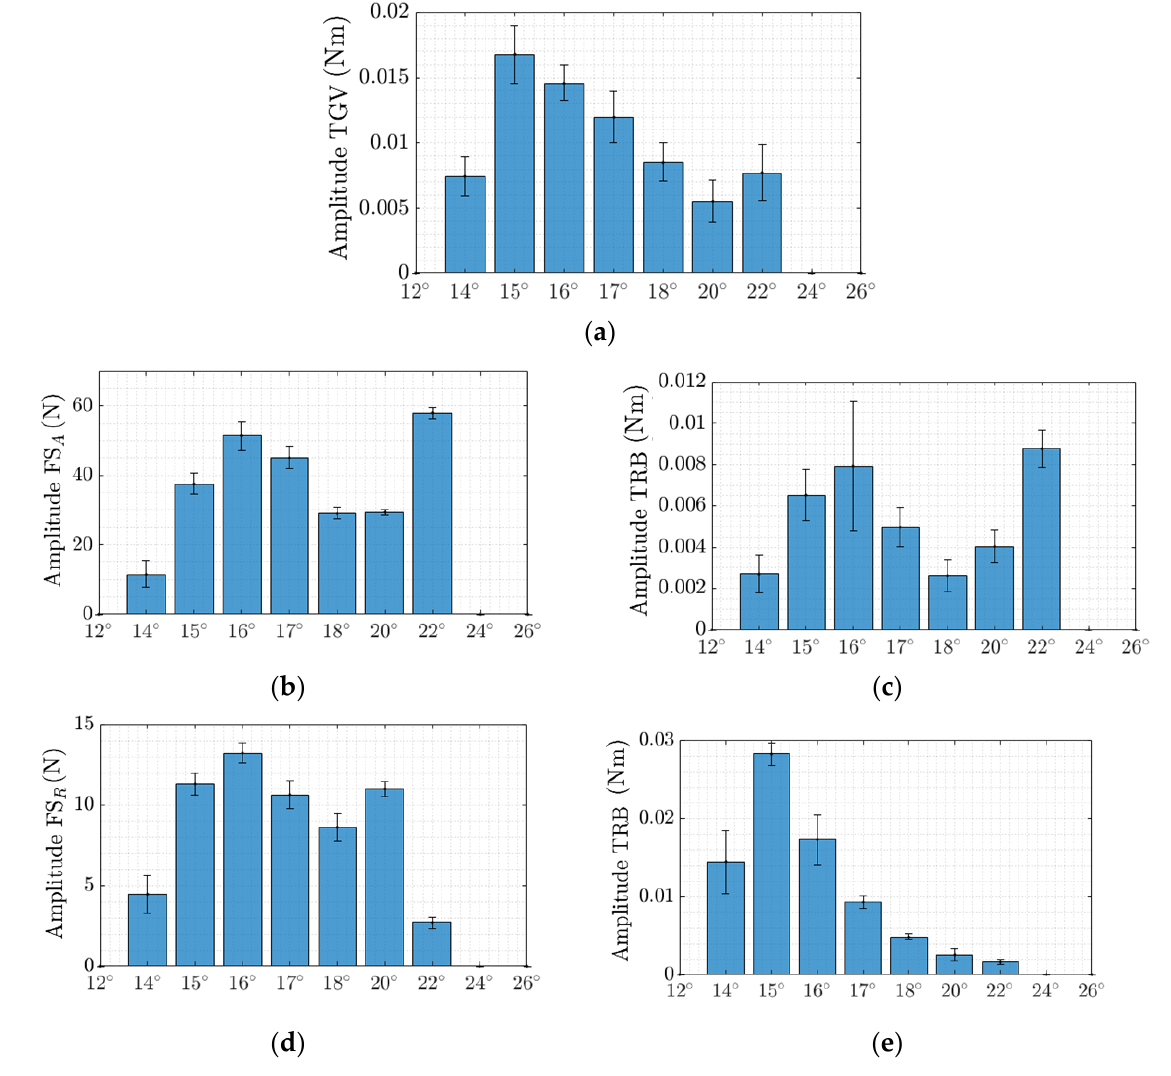
Figure 10. Guide vane torque levels at f rvr (TGV) ( a ), turbine bearing axial force levels at f rvr (FS A ) ( b ), blade torque levels at f rvr (TRB) ( c ), turbine bearing radial force levels at f sr (FS R ) ( d ), and blade torque levels at f rr (TRB) ( e ) at α from 12° to 26°.